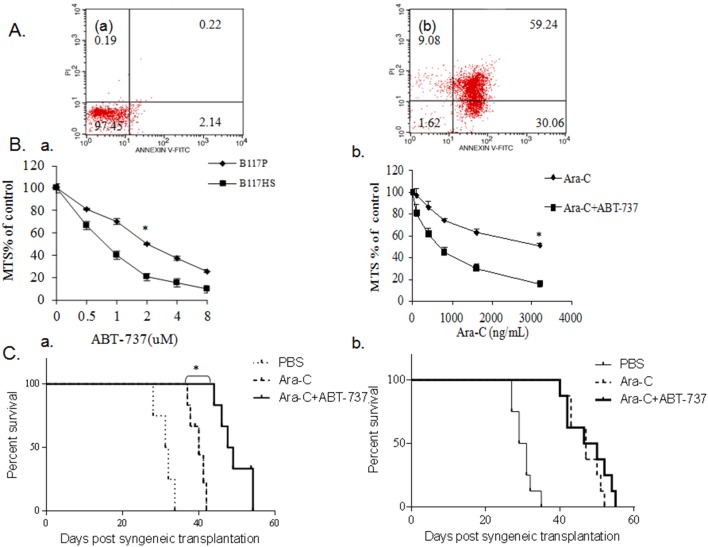
Sensitivity of Ara-C resistant leukemic cells to an inhibitor of anti-apoptosis proteins (ABT-737).Fig. 6A) In vitro induced apoptosis of B117HS cells by ABT-737. B117HS cells were treated with either DMEM medium as control (a) or with 2.0 µM of ABT-737 (b) for two days, followed by apoptosis analysis according to the Methods. Fig. 6B) Sensitivity of B117P and B117HS cells to ABT-737 (a). Cells were treated with 0.5 µM∼8 µM of ABT-737 for three days prior to the MTS assay as described in the Methods. *p<0.05. Sensitivity of B117HS cells to Ara-C alone or in combination with ABT-737. (b). B117HS cells were treated with Ara-C alone or Ara-C combined with 0.4 µM of ABT-737 for three days prior to the MTS assay as described in the Methods. *p<0.05. Fig. 6C) Kaplan-Meier curves of recipient mice treated with Ara-C alone or in combination with ABT-737. B6C3F1 mice were infused with 2×105 B117HS cells (a) or B117P cells (b), followed by the treatment with PBS, Ara-C (50 mg/kg), or Ara-C (50 mg/kg) and ABT-737 (25 mg/kg), respectively. Each group contained 8 mice. *p<0.05.